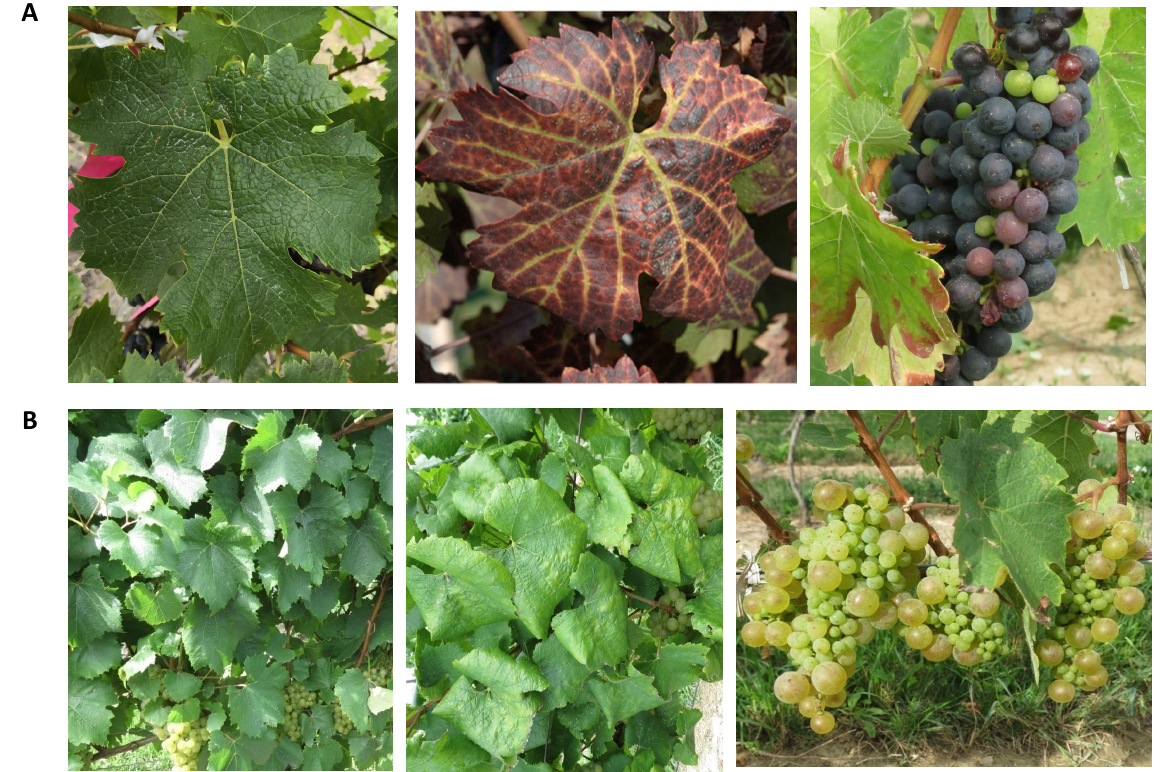
Figure 2. Symptomatology of grapevine cv. Cabernet franc ( A ) and cv. Chardonnay ( B ) infected with GLRaV-3. Left: leaf of vine not infected with GLRaV-3; middle: leaf of vine infected with GLRaV-3; right: berry cluster from GLRaV-3 infected plants. The typical leaf symptoms of GLRaV-3 infection, downward rolling of leaf margins and interveinal discoloration (reddening in dark-berried grapevines and chlorosis in white-skinned cultivars) are readily seen. Photos in B are from Shabanian et al. (2020)